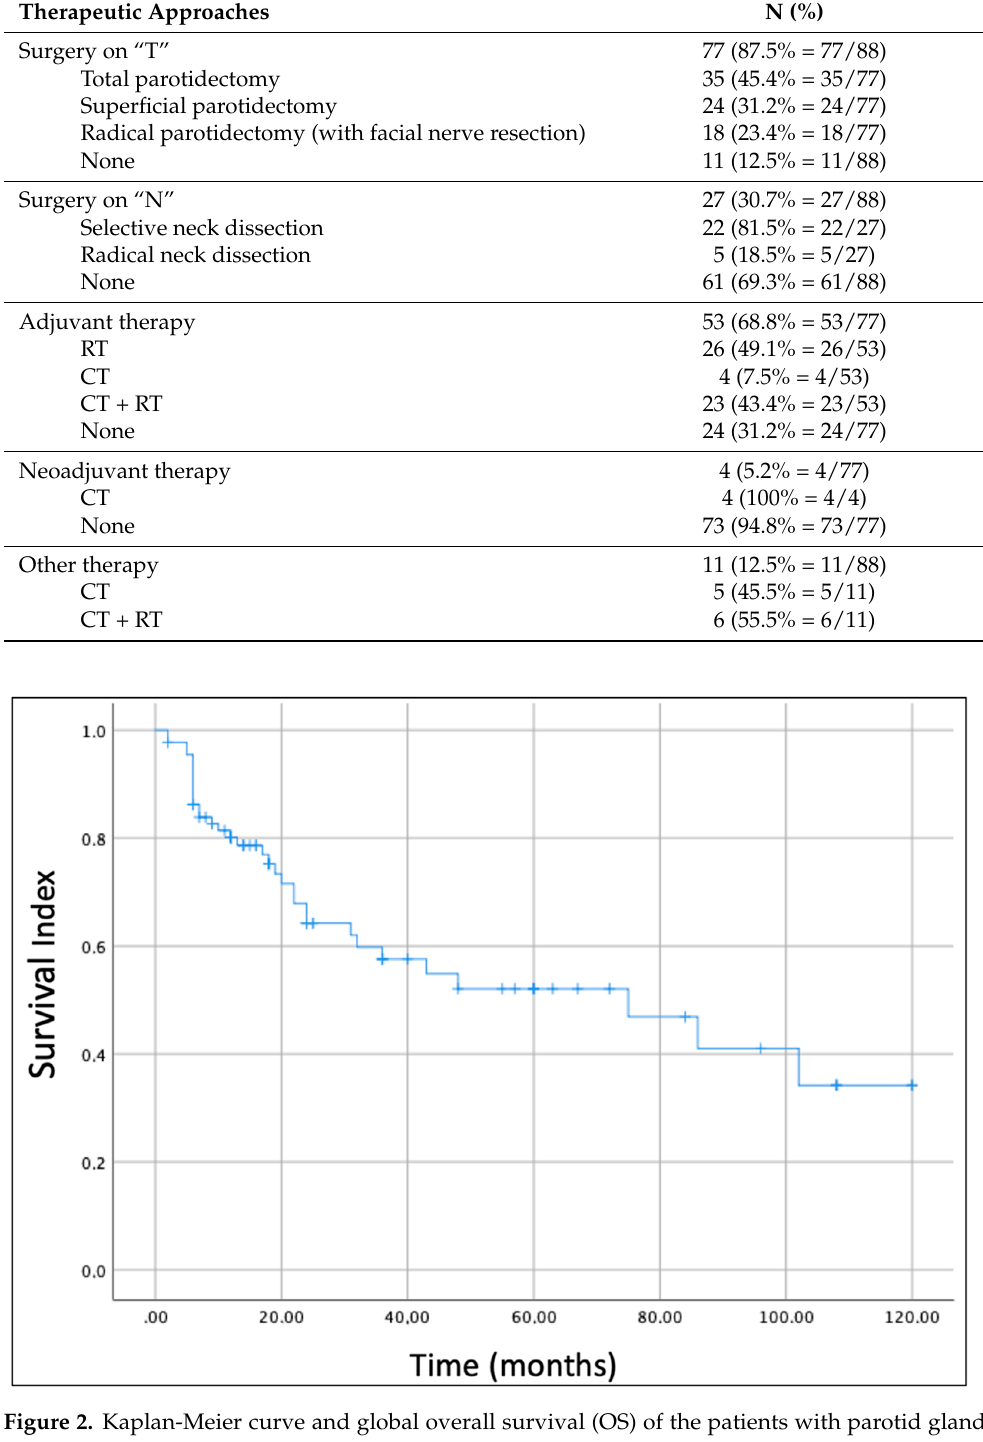
Table 4. Main therapeutic approaches for the parotid gland sarcomas included in this study. Therapeutic Approaches